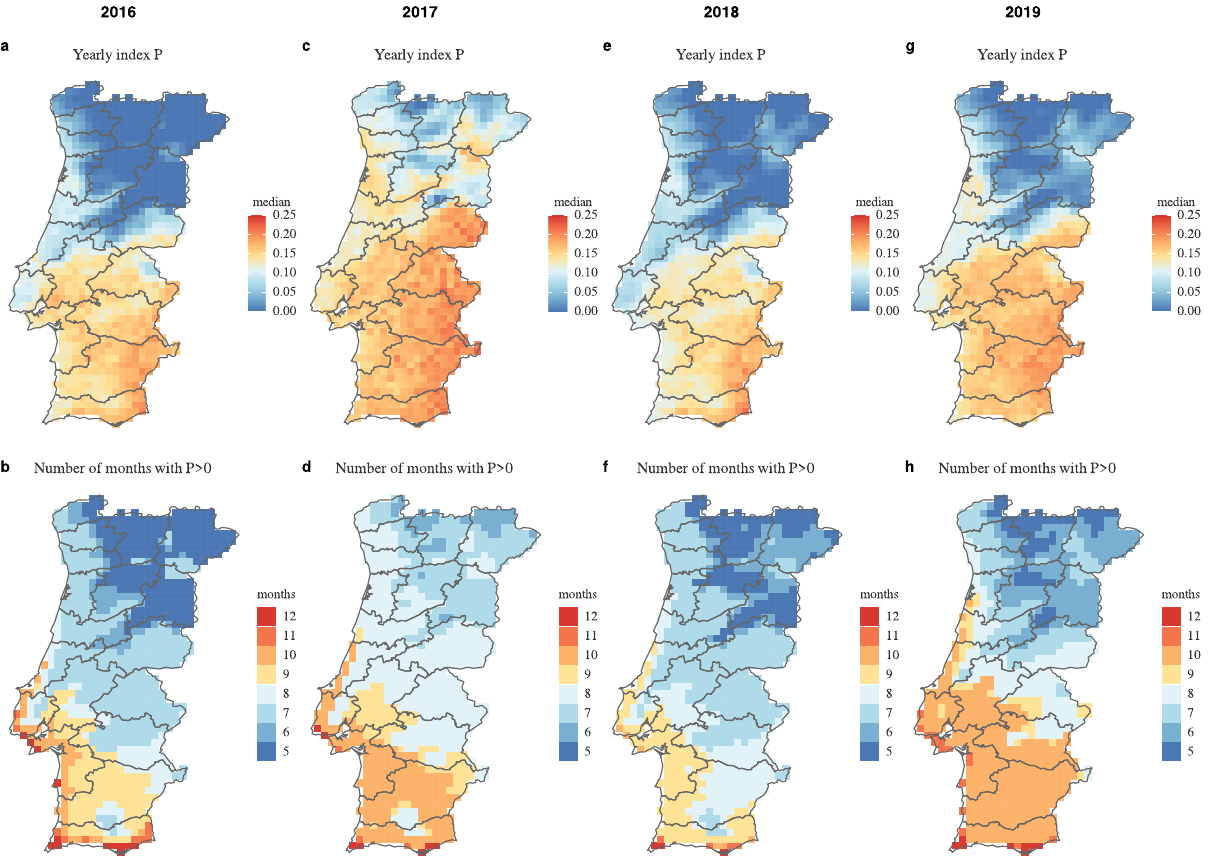
Fig. 5 Estimated WNV transmission potential across Portugal (2016 – 2019). Maps present summary statistics of estimated index P (WNV transmission potential) at the spatial resolution available in the climate dataset. a , c , e and g Present the yearly median index P per coordinate according to the presented color scale on the right. b , d , f and h Present the number of months during each year for which the estimated index P per coordinate was above zero, according to the presented color scale on the right. Boundaries in dark grey represent districts.